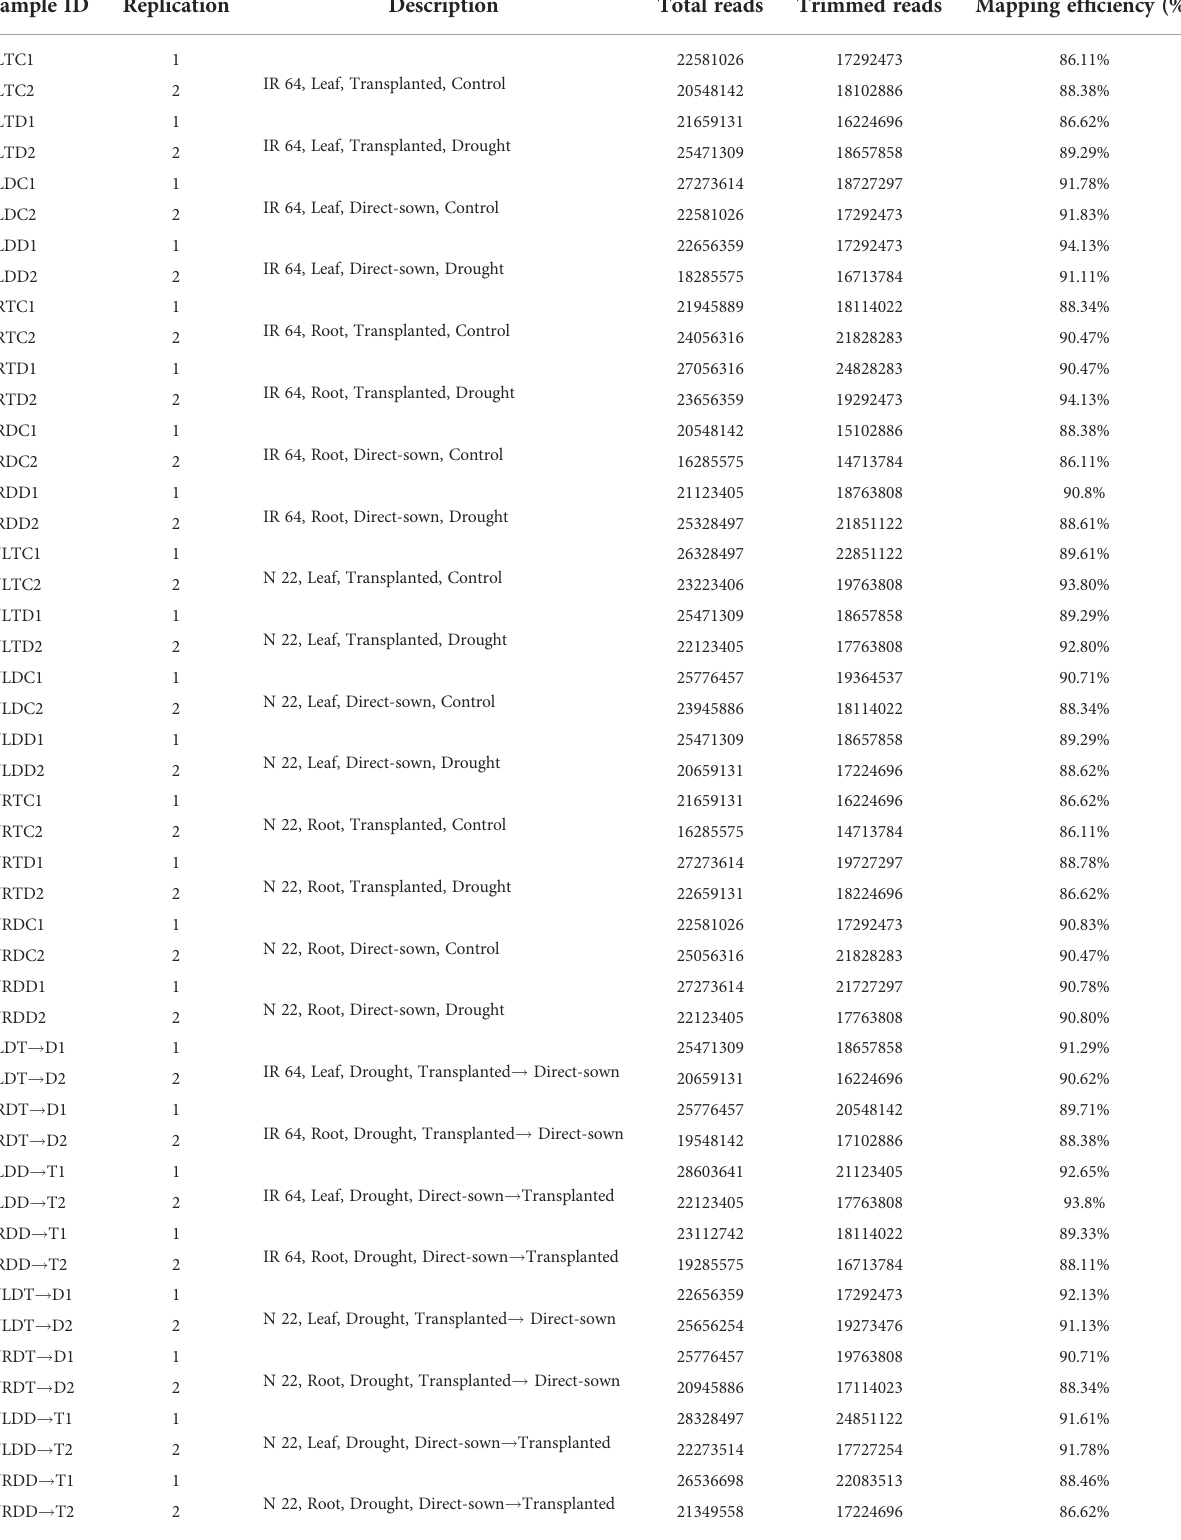
TABLE 1 Summary of RNA-seq data mapping statistics for leaf and root tissues from rice cultivars (IR 64 and Nagina22) grown by direct-sowing and transplanting, and then by changing the method of planting (Transplanted ! Direct-sown, T ! D; Direct-sown ! Transplanted, D ! T) under control conditions and imposition of drought stress at